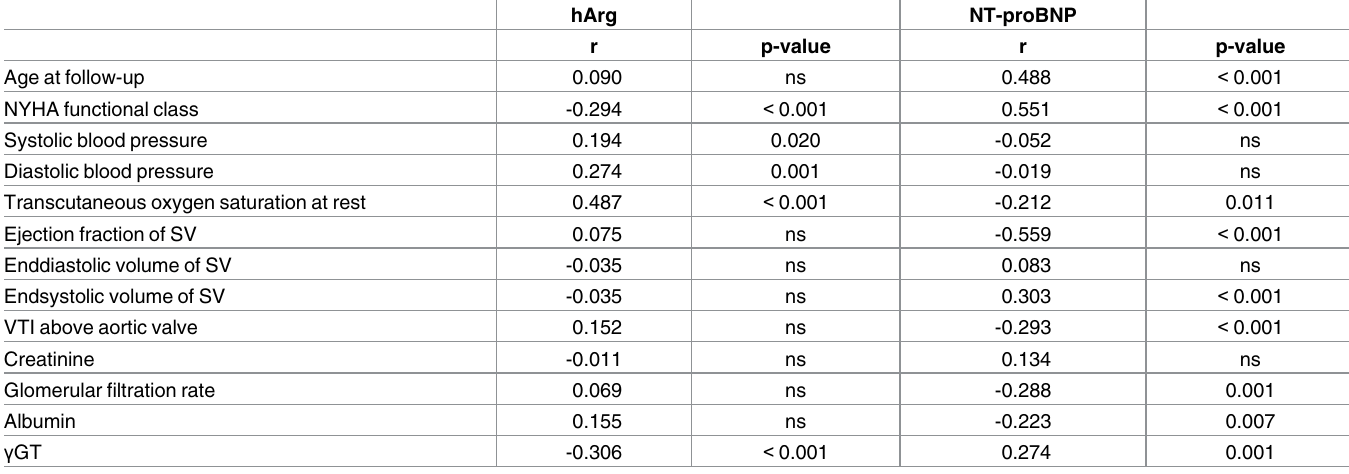
Table 2. Relation of hArg and NT-proBNP with different variables * .